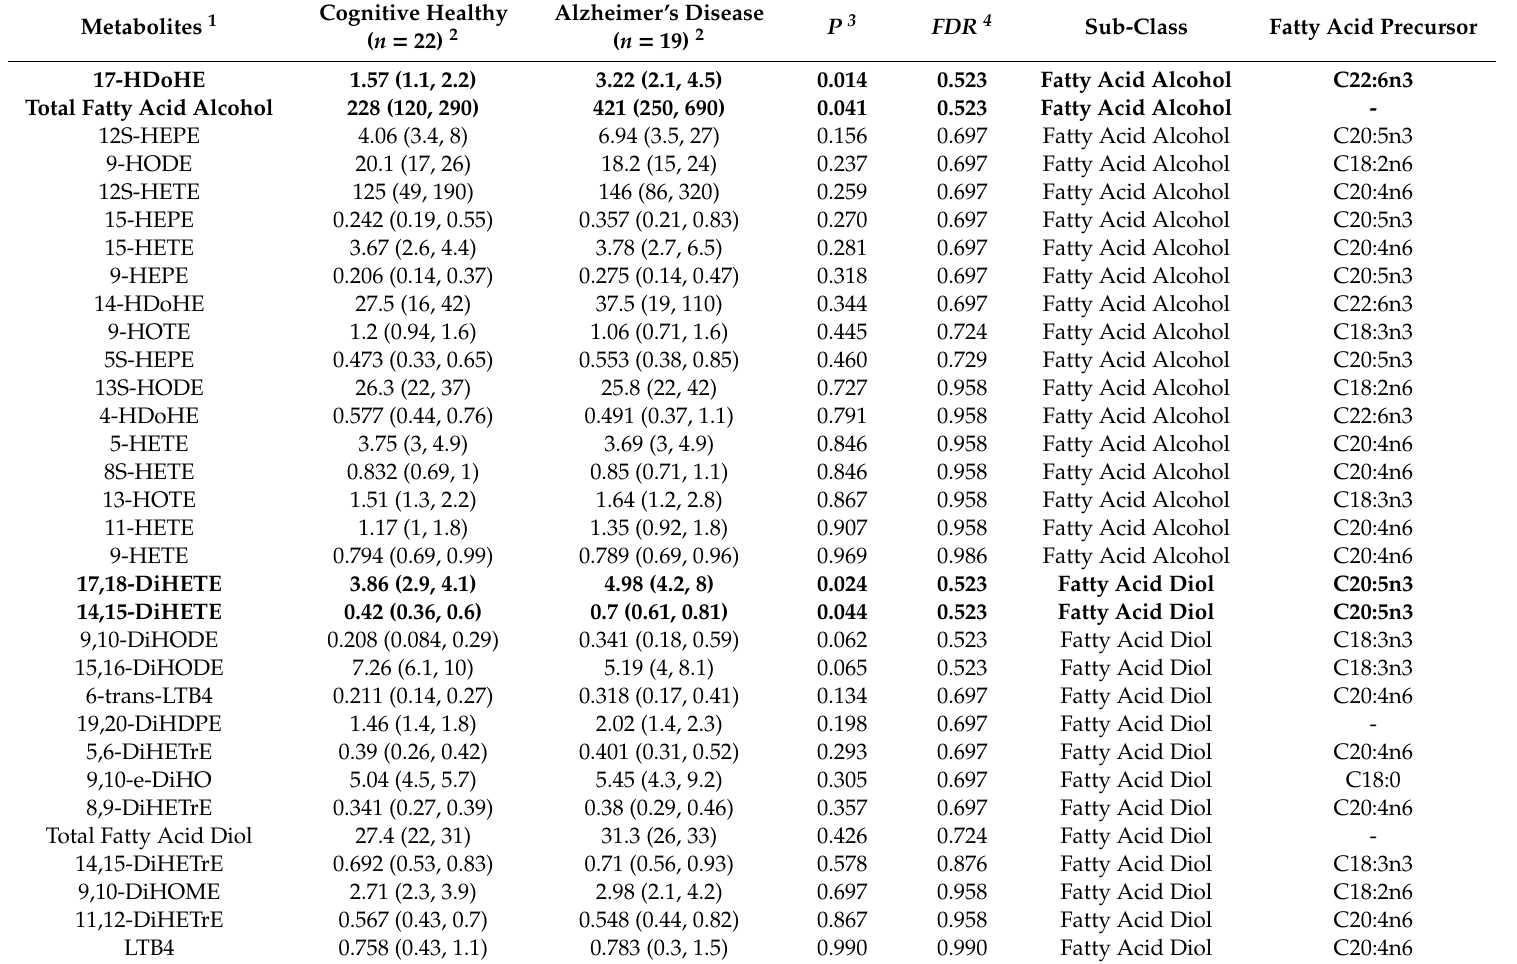
Table 2. Serum oxylipin concentrations and AD status in overnight-fasted Type 2 Diabetic elderly